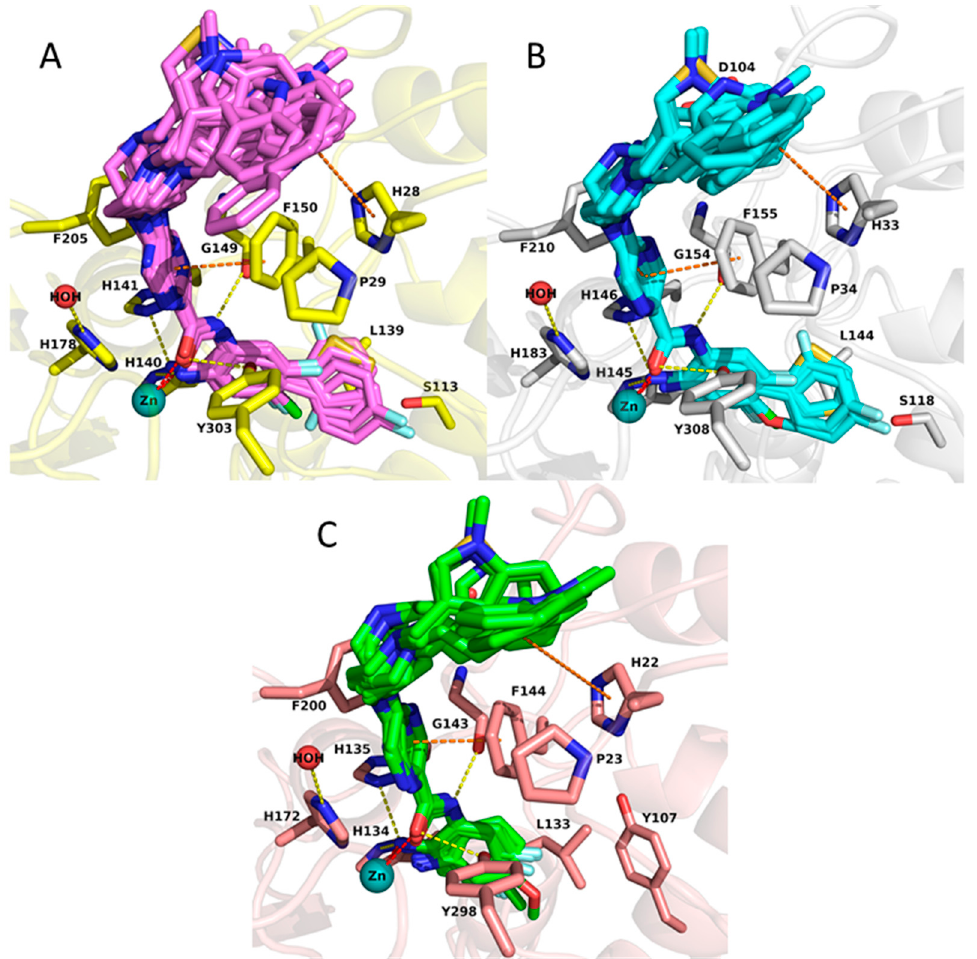
Figure 4. Docking poses of studied inhibitors having IC 50 values obtained for HDAC1 ( A ), HDAC2 ( B ), HDAC3 ( C ). The carbon atoms of the shown residues are colored as following: yellow in HDAC1, white in HDAC2 and salmon in HDAC3. Zinc ions are shown as cyan spheres, water molecules as red spheres. Inhibitors are shown in stick representation and their carbon atoms are colored pink, cyan and green in HDAC1, HDAC2 and HDAC3, correspondingly. Zinc coordination is shown as red dashed lines, hydrogen bonds as yellow, and aromatic interactions as orange.